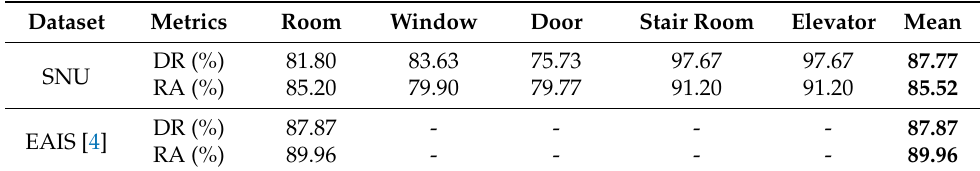
Table 4. Performance comparison of indoor models.